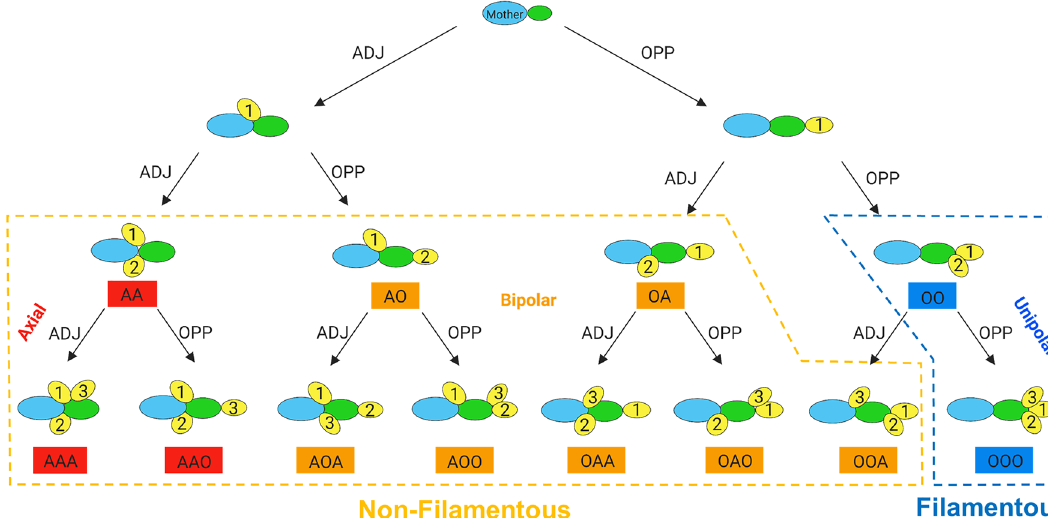
Figure 1. Schematic diagram of how the budding pattern is obtained from the bud site sequence of a new daughter cell. Bud site sequence is assigned for new daughters with both two and three bud sites and categorised to its corresponding budding pattern as shown. For cells growing in non-filamentous form, haploids will mostly adopt an axial pattern (red). This pattern is defined as new buds emerging consistently adjacent to the junction to the mother. Haploids under certain conditions and diploids will adopt a bipolar pattern (orange) whereby buds may emerge either adjacent or opposite the junction to the mother. When filamentous growth occurs, both cell types transition to a unipolar budding pattern (blue). This pattern is defined as new buds emerging consistently from the end opposite the junction to the mother. In this way, budding pattern can be used as a proxy for tracking filamentous growth in liquid media 2,5,12–15